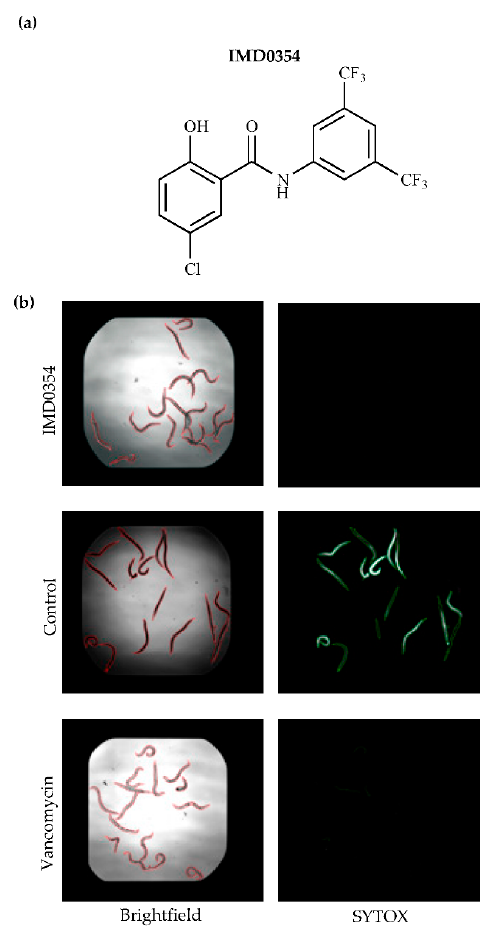
Figure 1. IMD0354 rescues C. elegans from MRSA infection. ( a ) Chemical structure of IMD0354. ( b ) Fifteen MRSA-infected C. elegans were treated with 7.14 µg/mL IMD0354, 0.1% dymethlyl sulfoxide ( b ) Fifteen MRSA-infected C. elegans were treated with 7.14 µ g / mL IMD0354, 0.1% dymethlyl sulfoxide (DMSO) (control) and 10 µg/mL vancomycin for 5 days. After staining dead worms with SYTOX (DMSO) (control) and 10 µ g / mL vancomycin for 5 days. After staining dead worms with SYTOX Orange, brightfield (left) and fluorescence (right) images were obtained. Orange, brightfield (left) and fluorescence (right) images were